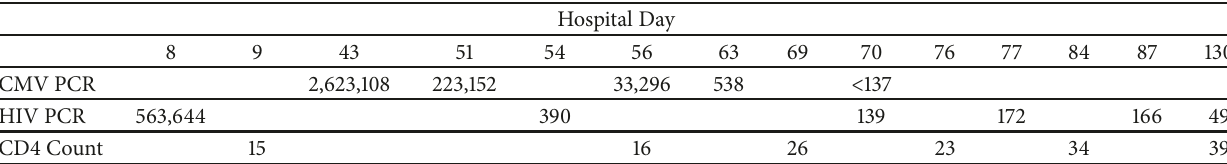
Table 2: PCR and CD4